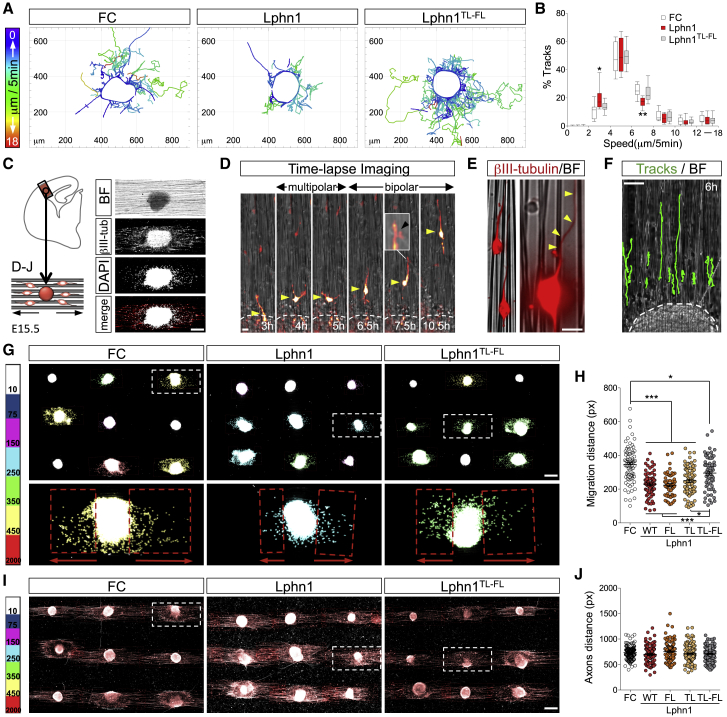
Latrophilin Interaction with Teneurin and FLRT Slows Down Cell Migration In Vitro(A) Time-lapse analysis of cortical neurons exiting E15.5 cortical explants on surfaces coated with FC (control), Lphn1 (Lec-Olf), or Lphn1TL-FL (Lec-Olf) proteins. Neurons were tracked (lines) and colored based on the speed of migration.(B) Average speed frequency distributions. n > 10 movies per condition. ∗p < 0.05, ∗∗p < 0.01, one-way ANOVA test with Tukey’s post hoc analysis.(C) Diagram depicting the nanofiber assay.(D) Snapshots from a time-lapse video of an mCherry-expressing neuron (red) migrating on nanofibers coated with FC control protein. A yellow arrowhead points to the cell soma. The transition from multipolar to bipolar morphology is visible. The leading process showed occasional branching (magnification, black arrowhead).(E) Cortical neurons stained with β-III-tubulin (red) with bipolar morphology (left) and an example of a leading process switching to a neighboring fiber (right, yellow arrowhead).(F) Tracks (green) from time-lapse imaging of neurons migrating on nanofibers.(G) Explants growing on nanofibers coated with FC, Lphn1, and Lphn1TL-FL Lec-Olf for 2 DIV. DAPI staining is color-coded based on the average distance from the explant, indicating length of migration (see also Figure S4E).(H) Quantification of the data shown in (G). n = 144 explants (36 explants per experiment, 4 experiments per condition). See full images in Figure S4F. ∗p < 0.05, ∗∗p < 0.01, ∗∗∗p < 0.001, one-way ANOVA test with Tukey’s post hoc analysis.(I) The same explants as shown in (G), stained using β-III-tubulin.(J) Quantification of the data shown in (I). n = 144 explants (36 explants per experiment, 4 experiments per condition) as described in (H).Scale bars represent 150 μm (C), 15 μm (D and E), and 250 μm (F, G, and I).